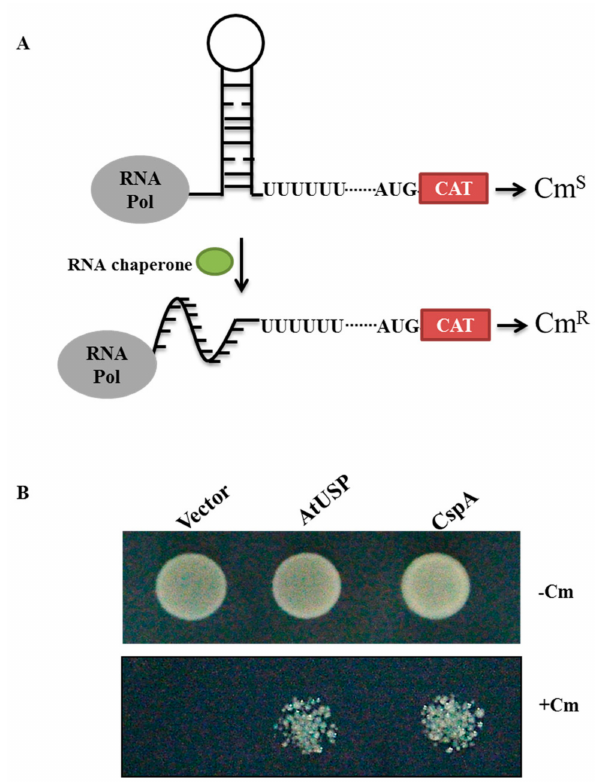
Figure 6. AtUSP displays anti-termination activity in chloramphenicol acetyltransferase (CAT) gene transcription in RL211 E. coli . ( A ) Schematic representation for the measurement of AtUSP anti-termination activity using RL211 E. coli cells, which contain a stem-loop RNA structure upstream of the chloramphenicol ( CAT ) gene. AtUSP can melt the stem-loop RNA hairpin structure, which results in CAT gene transcription and chloramphenicol (Cm) resistance. ( B ) pINIII vector, pINIII-AtUSP , or pINIII-CspA were transformed into RL211 cells harboring a chloramphenicol resistance gene downstream of the trpL terminator. Cells were incubated in media containing 0.5 mM isopropyl- β - D -thiogalacto-pyranoside (IPTG) with or without Cm. Equal volumes of cell cultures were spotted onto LB-carbenicillin agar medium with or without Cm and grown at 37 ◦